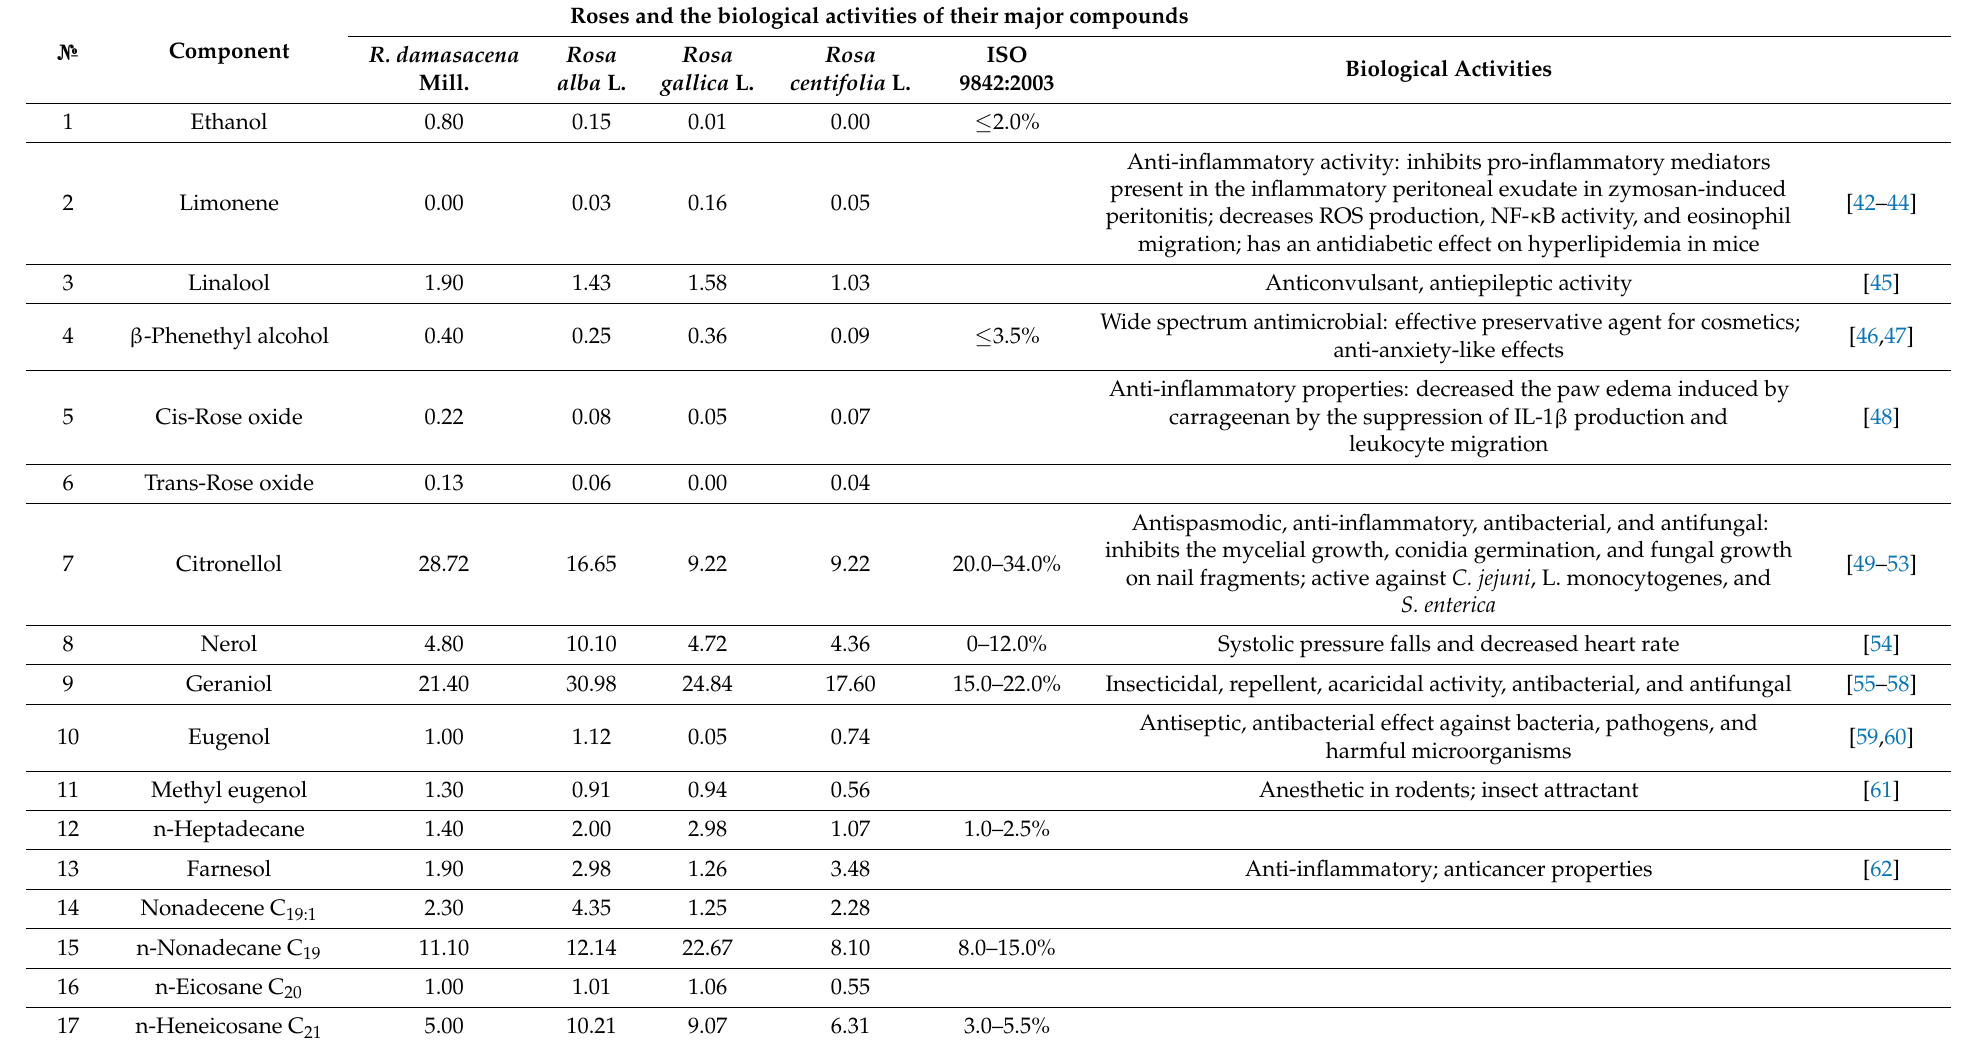
Table 1. The main oil-bearing roses used for rose oil production and the biological activities of their major